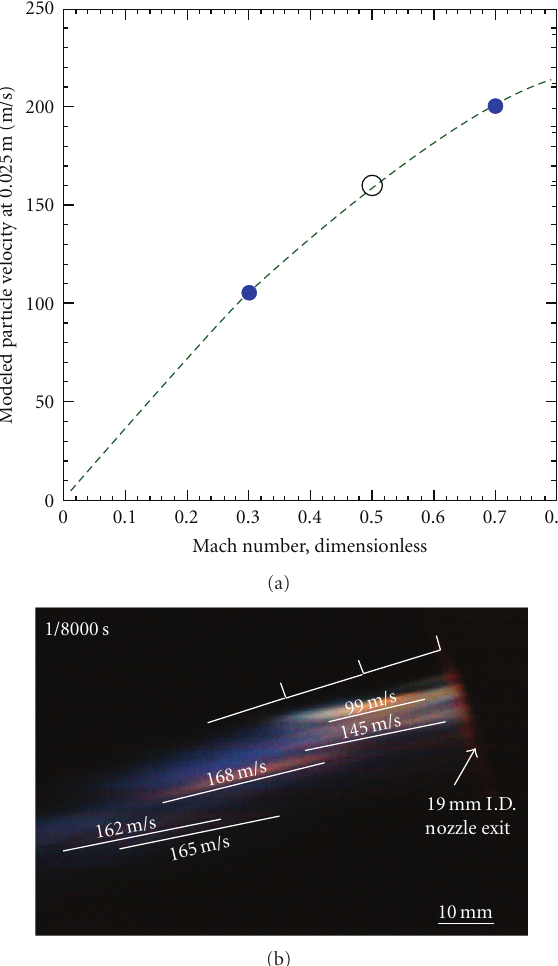
Figure 6: (a) Predicted particle velocities; (b) experimental mea- surements of particle velocity using a high-speed camera. Lines are drawn over particle traces for